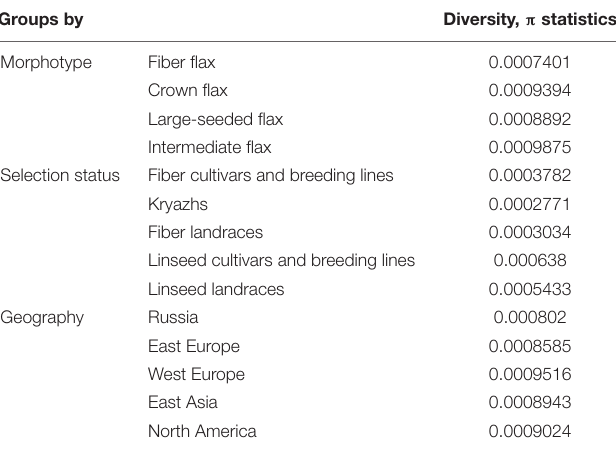
TABLE 1 | Diversity levels among different flax